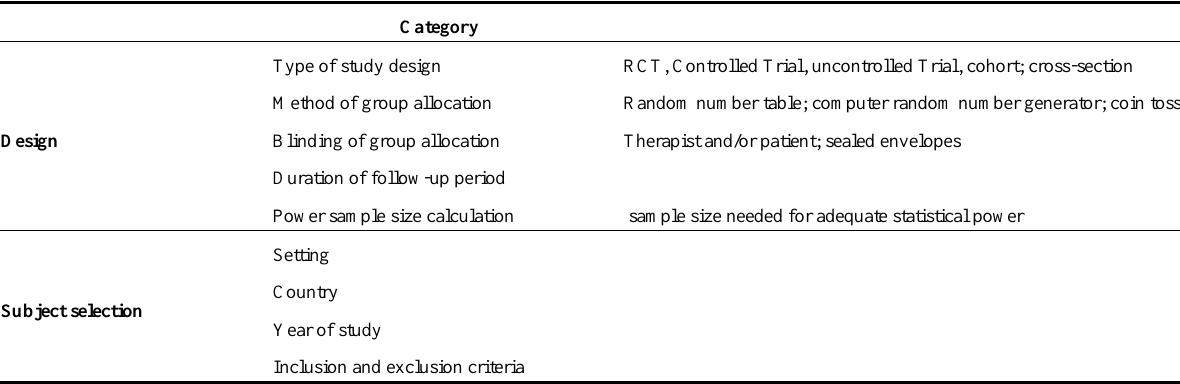
Table A2. Study description/characteristics